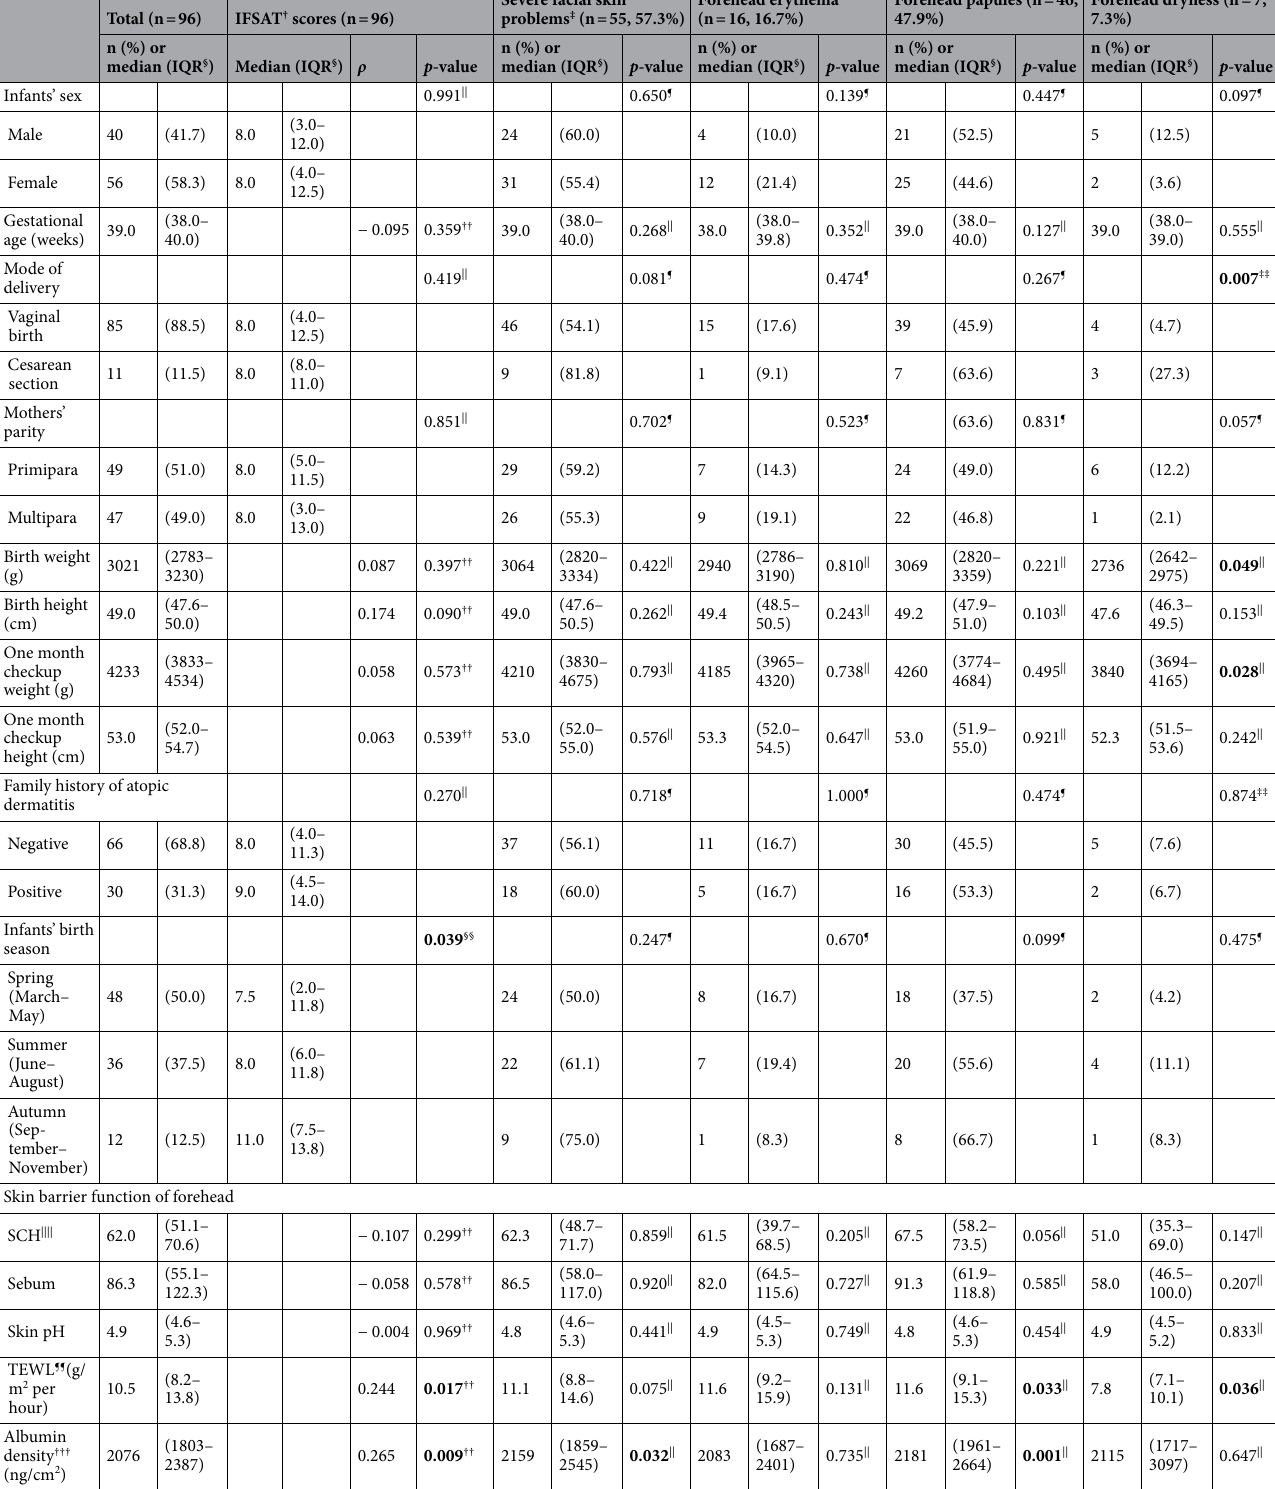
Table 1. Relationship of participants’ characteristics with IFSAT scores, severe facial skin problems, forehead erythema, forehead papules, and forehead dryness (n = 96). Significant values are in bold. † Infant facial skin visual assessment tool (score 0–53), ‡ ≥ 8 points in case of infant facial skin visual assessment tool, §